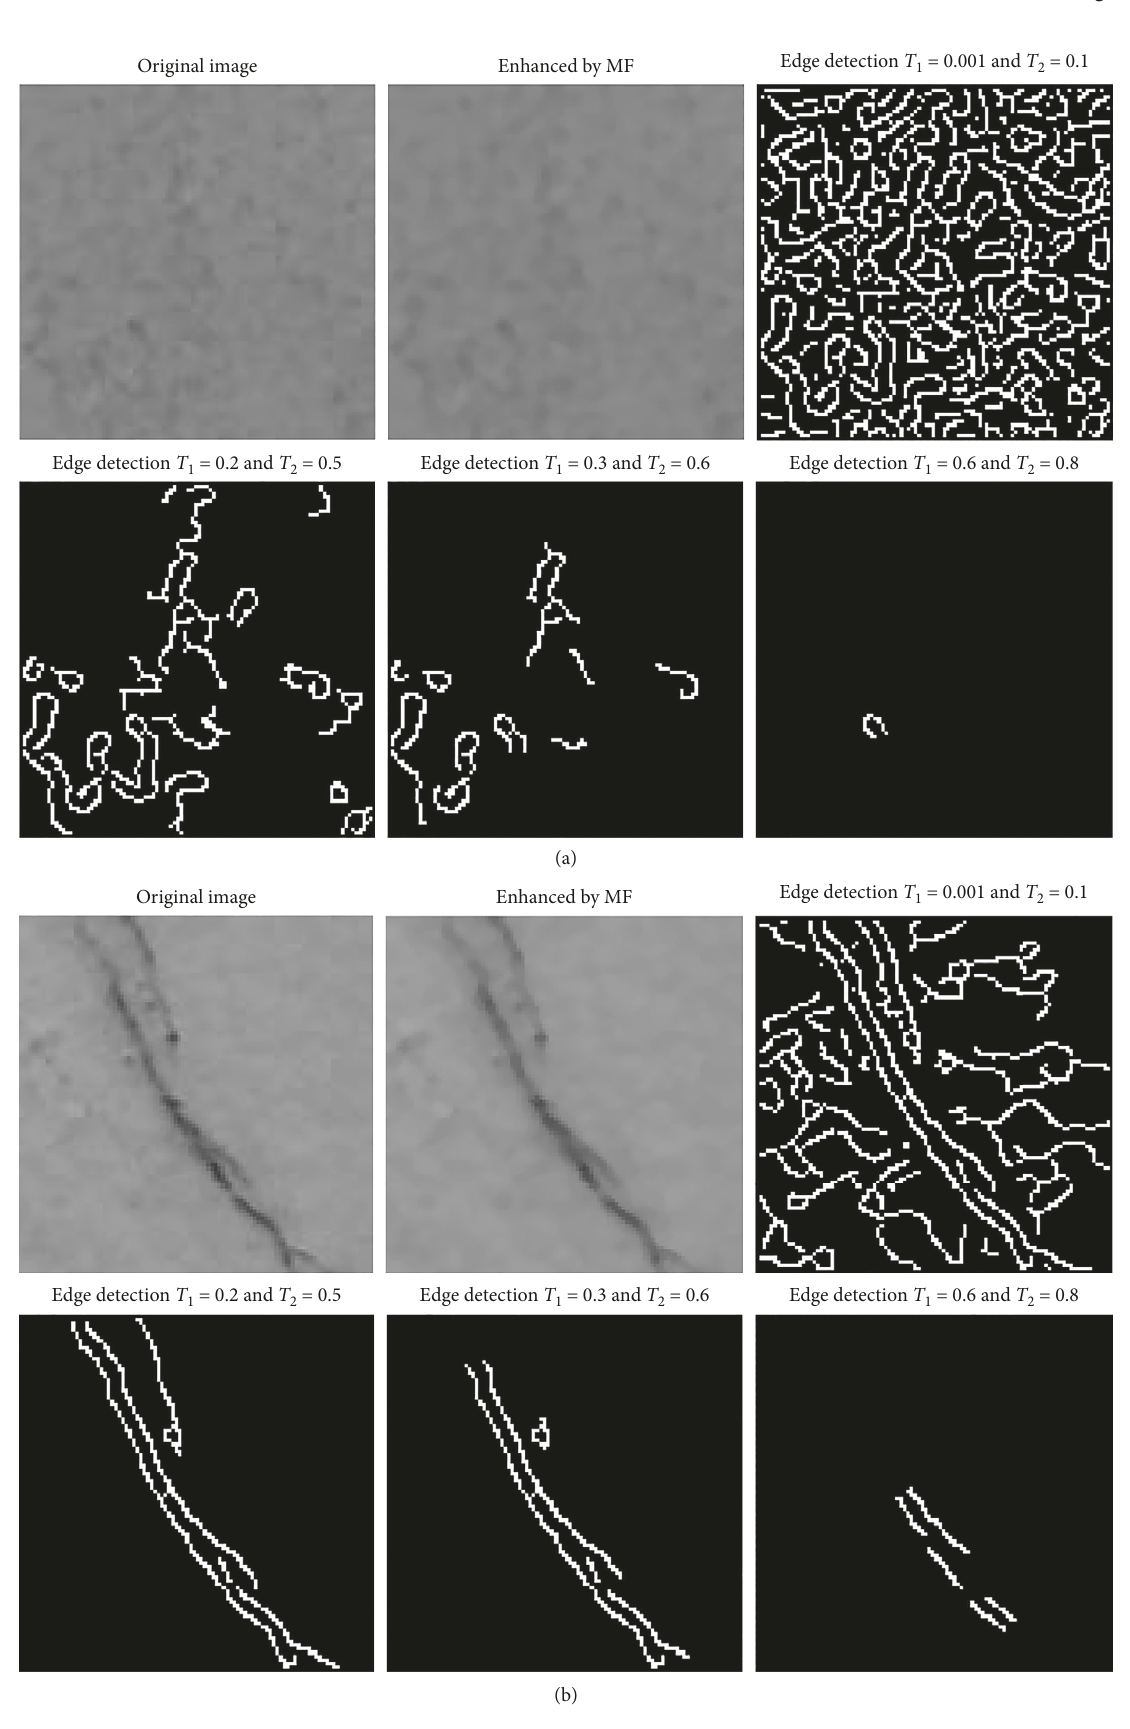
Figure 4: Edge detection outcome employing the Canny method: (a) an image without cracks and (b) an image with